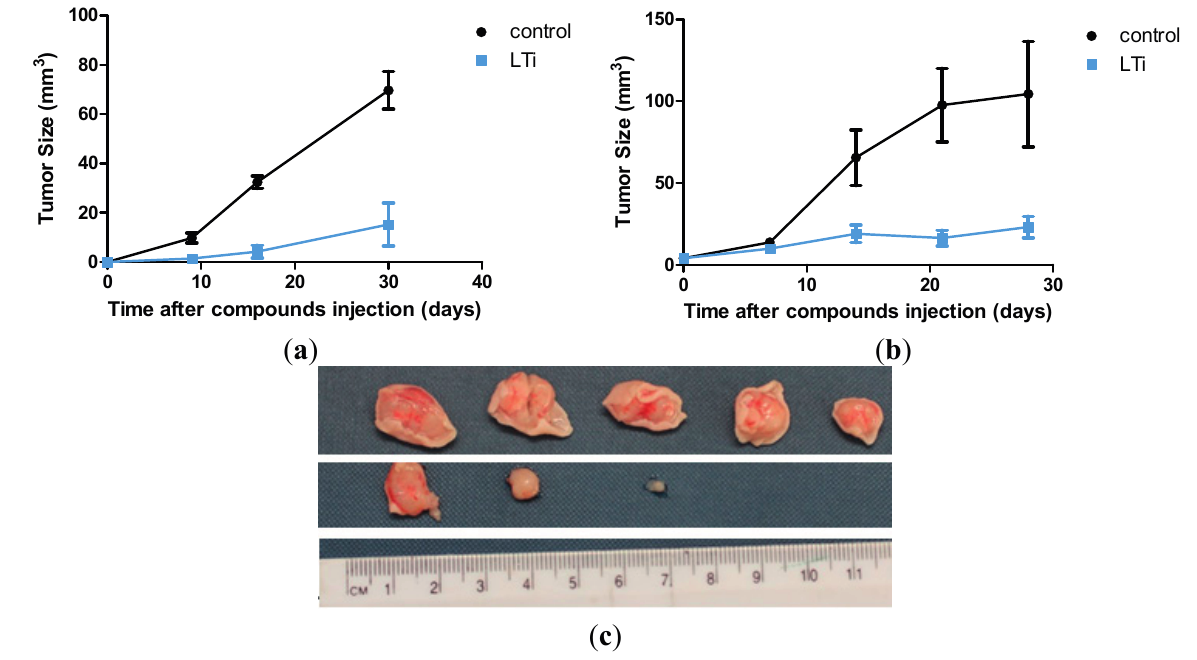
Figure 5. LTi reduces the development of solid tumors from colon cancer cells: immune deficient (nude) mice ( a ) N = 5; ( b ) N = 10 were inoculated S.C. with 5 × 10 6 HT-29, human colon adenocarcinoma cells and subjected to IP injection of LTi (100 µg/0.2 mL), every other day for three weeks. Control mice were injected with PBS. ( c ) Solid tumors at the termination of the experiment. Upper panel: control mice; Lower panel: treated mice (two-fifths were devoid of